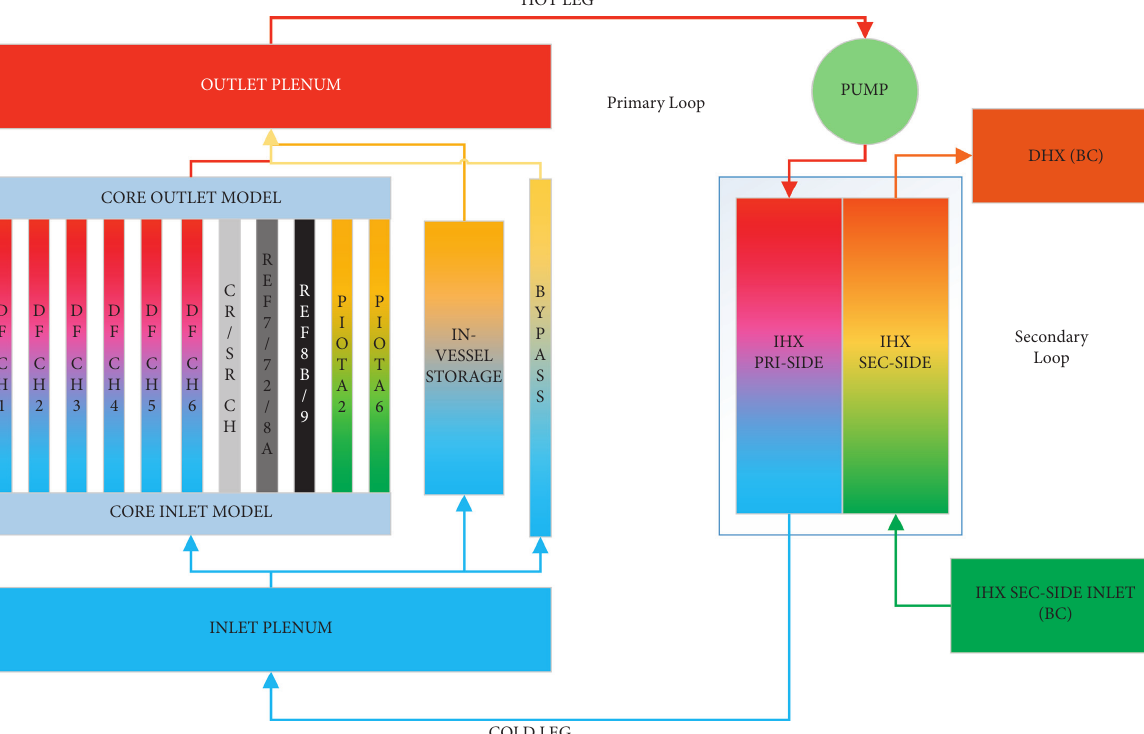
Figure 7: Simplified layout of FFTF Simulation